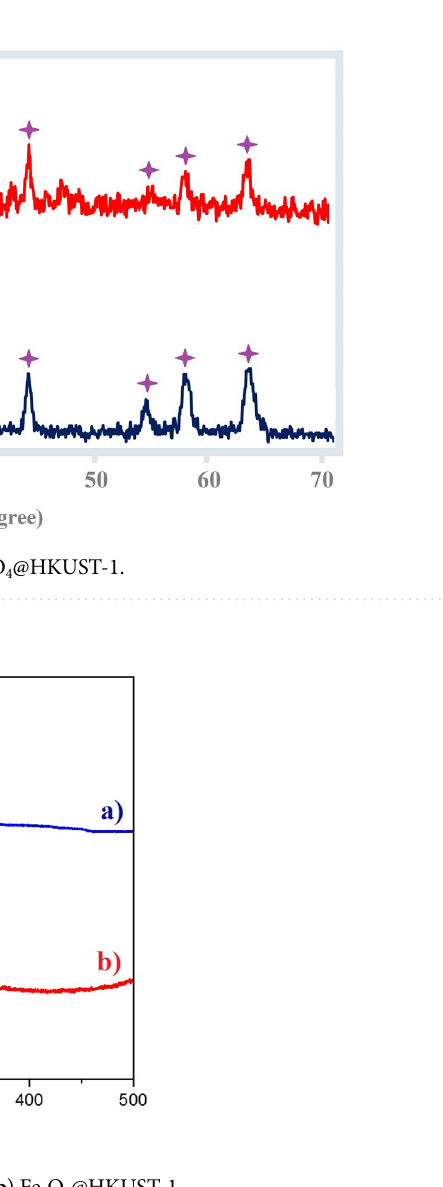
Figure 9. TGA graph of catalyst ( a ) Fe 3 O 4 and ( b ) Fe 3 O 4